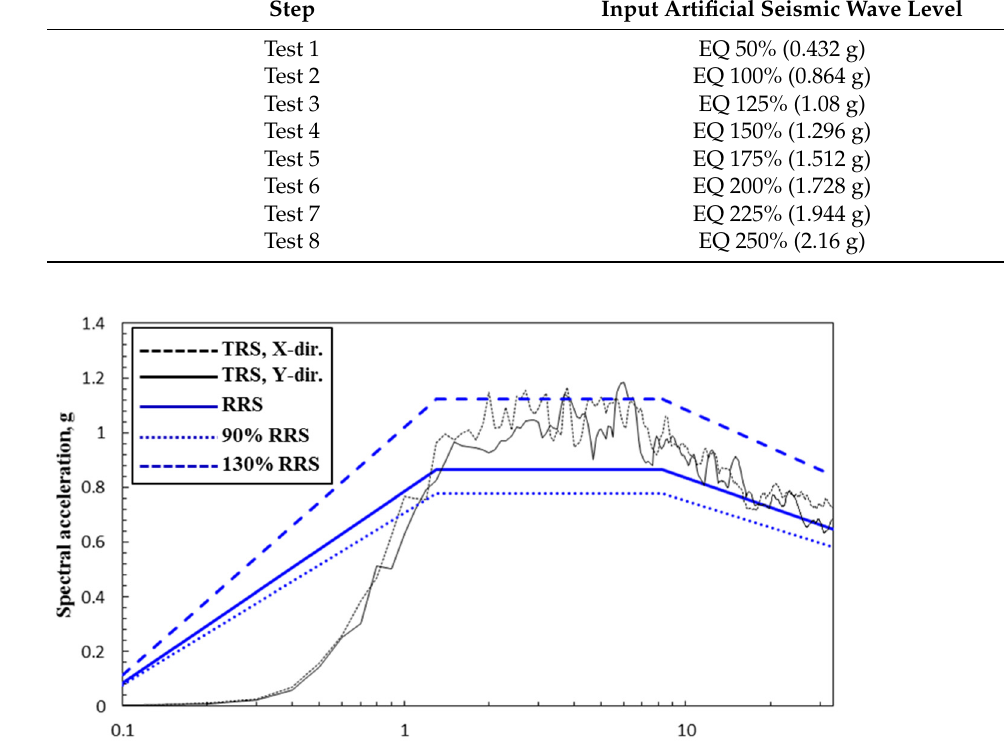
9 of 21 Table 3. Artificial seismic wave level used during the shaking table test.